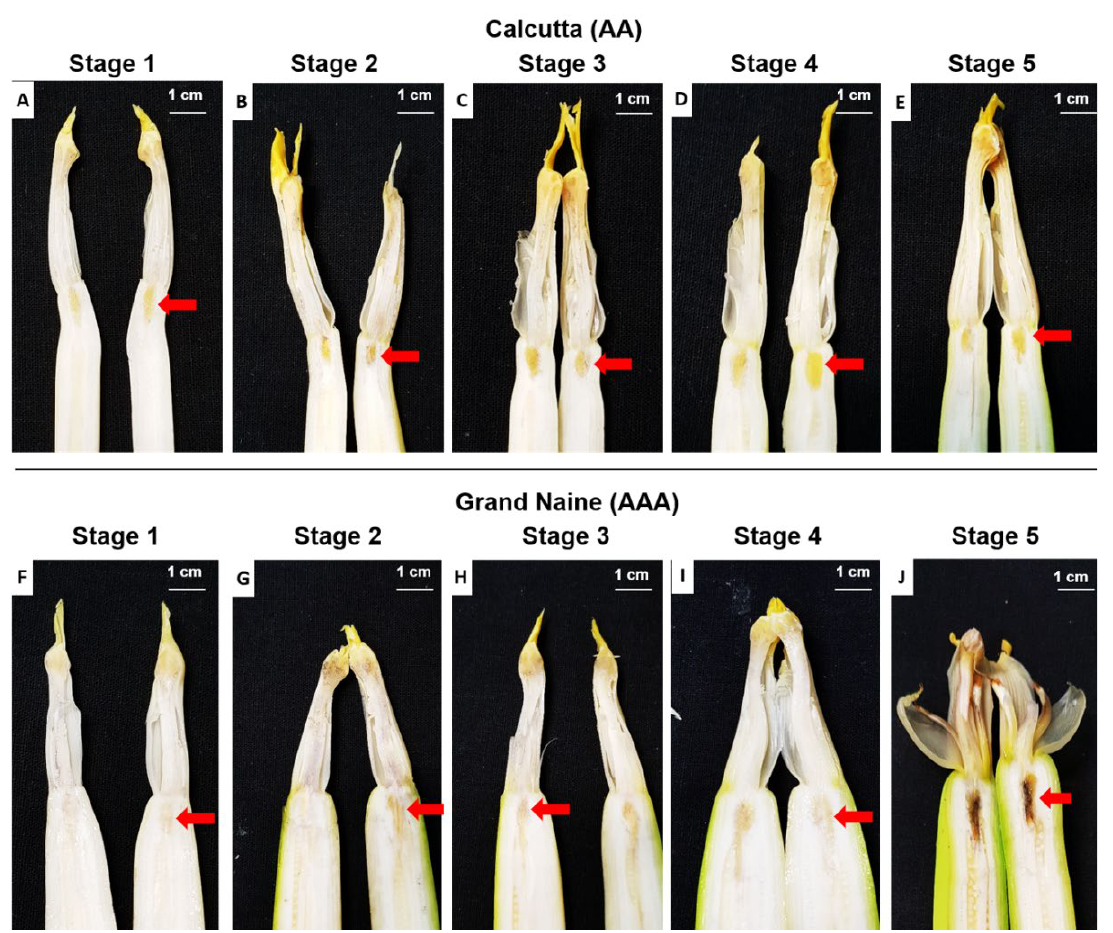
Figure 1. Longitudinal section of female flowers of Calcutta 4 and Grand Naine showing the nectary at different development stages. ( A , F ) stage 1: partial inflorescence emission from the pseudostem – vertical position (inflorescence base not visible); ( B , G ) stage 2: total emission of the inflorescence from the pseudostem – vertical position (visible base of the inflorescence); ( C , H ) stage 3: total inflorescence emission – horizontal position in relation to the ground; ( D , I ) stage 4: inflorescence pendulous to the pseudostem with closed flowers (pre-anthesis); ( E , J ) stage 5: Inflorescence pendulous to pseudostem with open flowers (anthesis) where Grand Naine displays nectary oxidation, while Calcutta 4 does not. Red arrow: Septal nectary. Table 1. Morphometric characteristics of septal nectary length and diameter of Calcutta 4 and Grand Naine cultivar at the five stages of floral